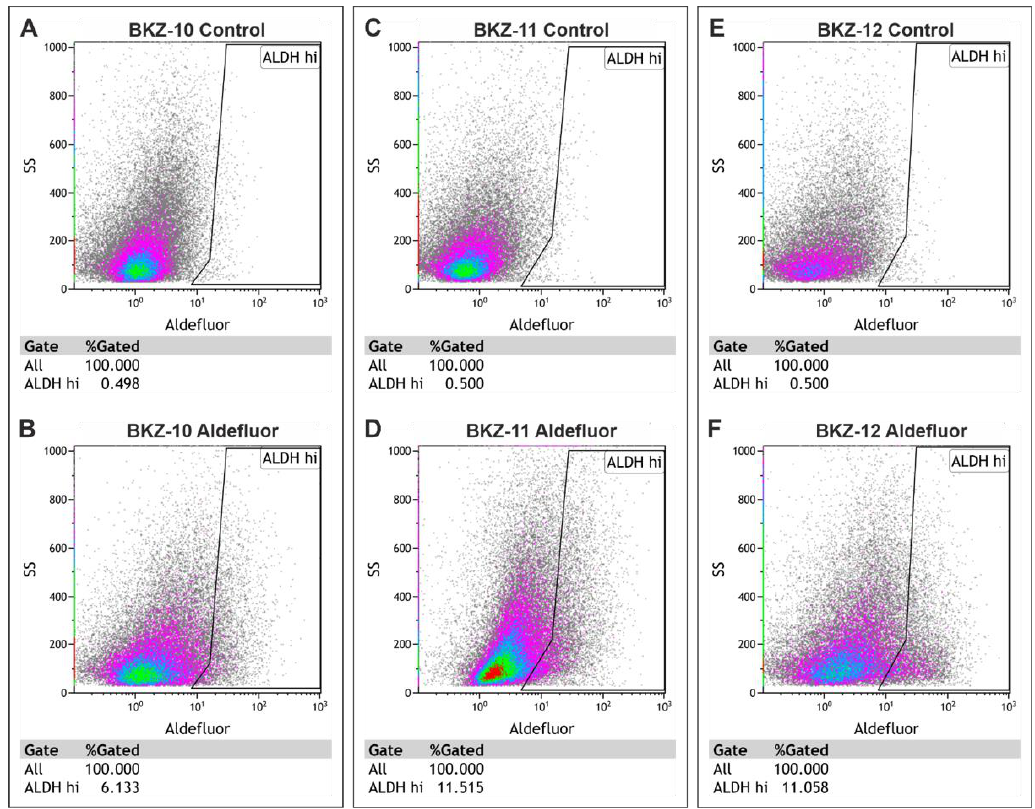
Figure 4. Established endometrial carcinoma-derived stem-like cell populations exhibit aldehyde dehydrogenase (ALDH) activity. Flow cytometric analysis of ALDH1 activity revealed ( B ) 6.133% ALDH high cells for BKZ-10, ( D ) 11.515% ALDH high cells for BKZ-11 and ( F ) 11.058% ALDH high cells for BKZ-12 in comparison to the respective control ( A , C , E ) with the specific ALDH inhibitor diethylaminobenzaldehyde (DEAB).